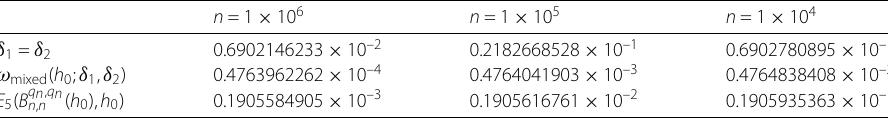
Table 5 The approximation error of B q n , q n n , n ( h 0 ) to h 0 by means of the mixed modulus of continuity